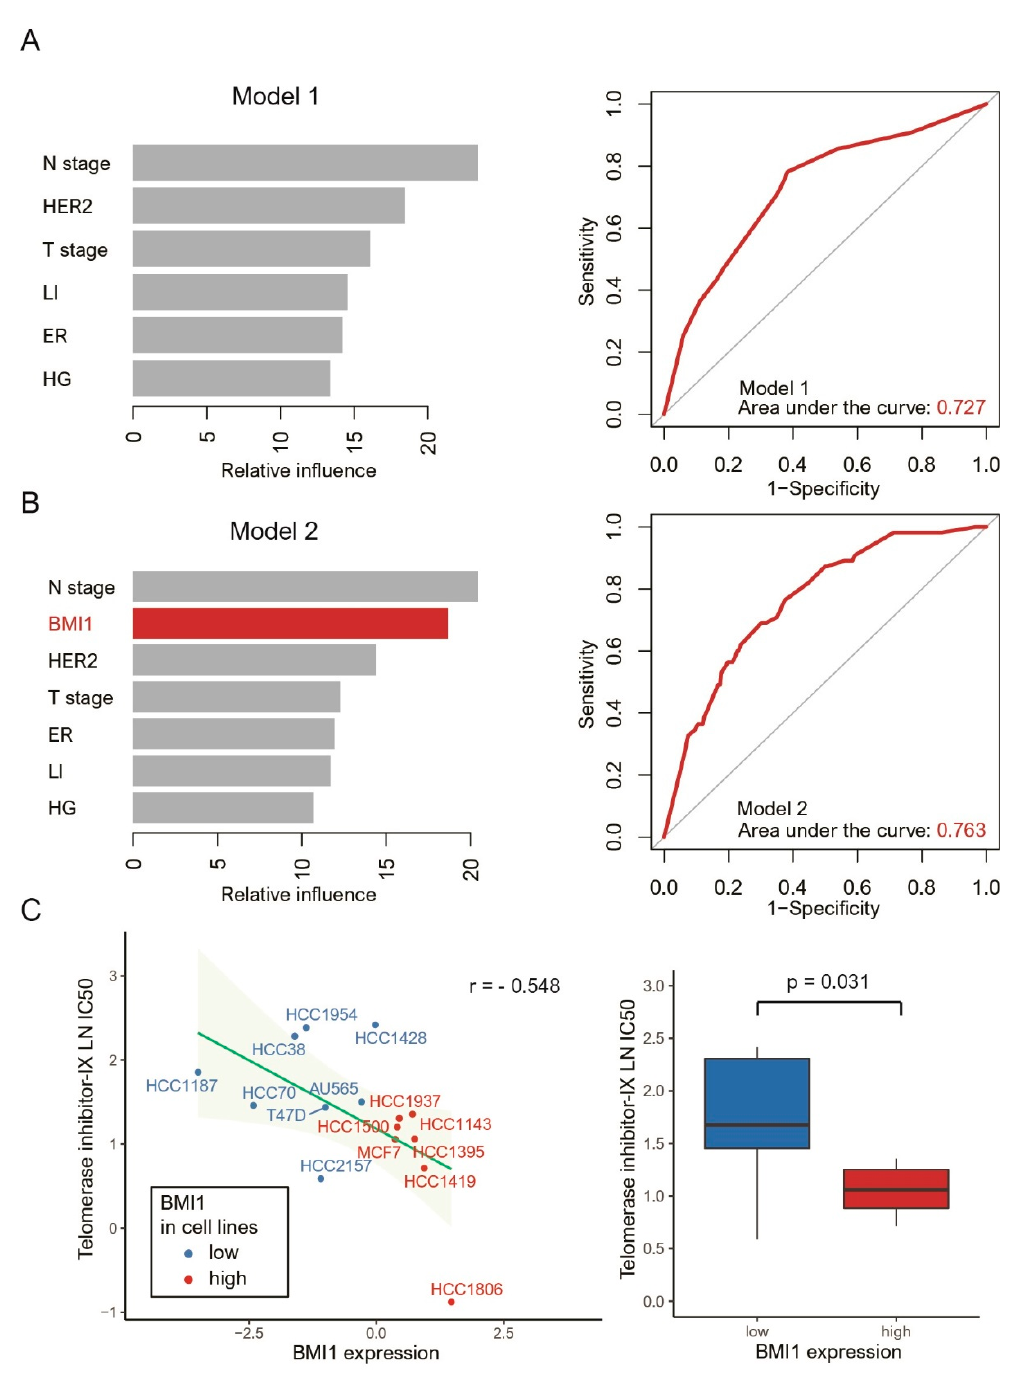
Figure 5. We applied supervised machine learning models for prognostic prediction using a gradient boosting machine (GBM). The covariates included the confounding factors (( A ) Model 1; T stage, N stage, histological grade (HG), lymphatic invasion (LI), estrogen receptor status (ER), and Human Epidermal growth factor Receptor 2 status (HER2) versus ( B ) Model 2; BMI1, T stage, N stage, HG, LI, ER, and HER2) and their relative importance using survival. Receiver operating characteristic curves for the GBM models were generated based on a multivariate Gaussian model. ( C ) Pearson correlations (left) and box plots (right) showing the natural log half-maximal inhibitory concentration (LN IC50) of telomerase inhibitor IX, the most potent anticancer drug against breast cancer cell lines with high BMI1 expression.